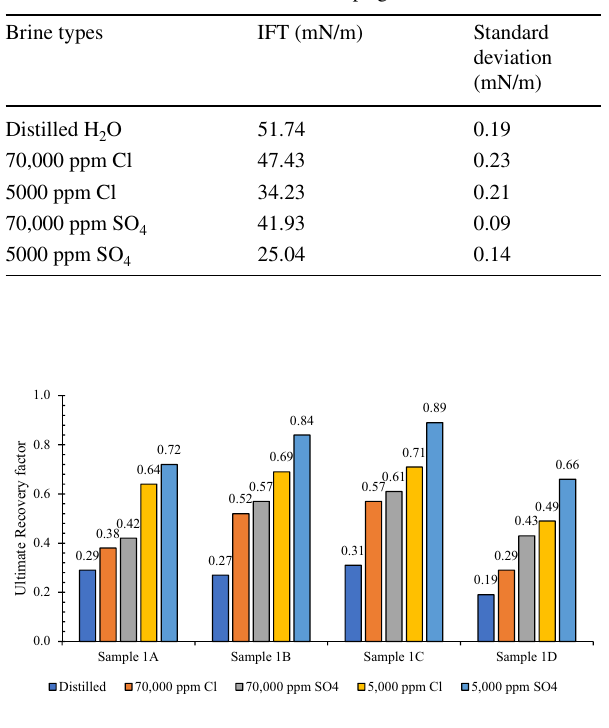
Fig. 17 Ultimate recovery of all experimental